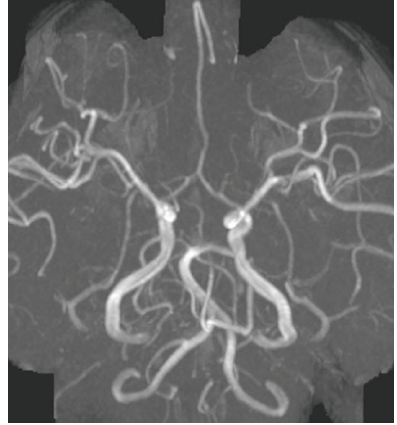
circulation.Fig. 4. Coronal T1 image at level of the third ventricle.Fig. 3. Axial inversion recovery image of frontal